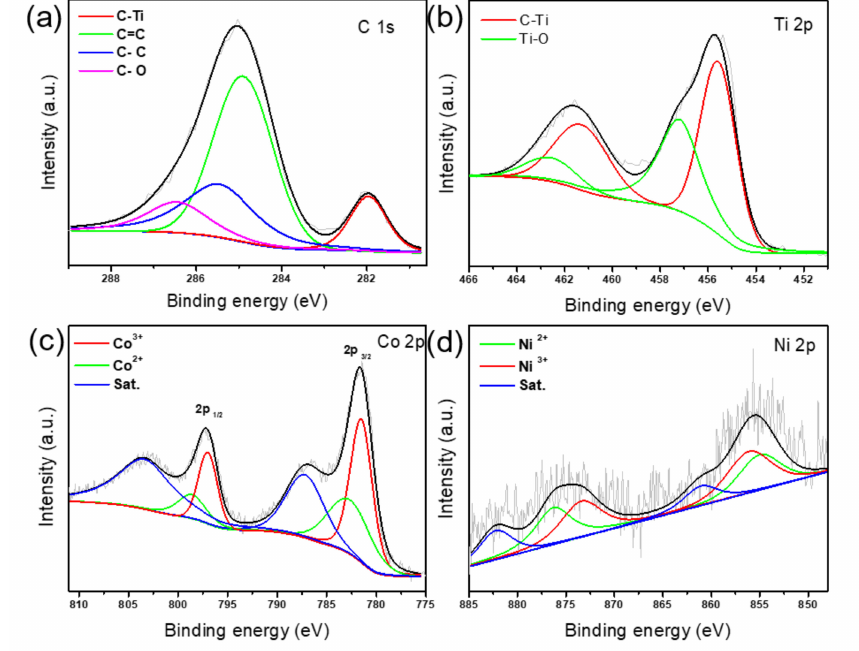
Figure 4. High resolution X-ray photoelectron spectroscopy (XPS) spectrum of ( a ) C 1s; ( b ) Ti 2p; ( c ) Co 2p and ( d ) Ni 2p for CoNi-ZIF-67@Ti 3 C 2 T x